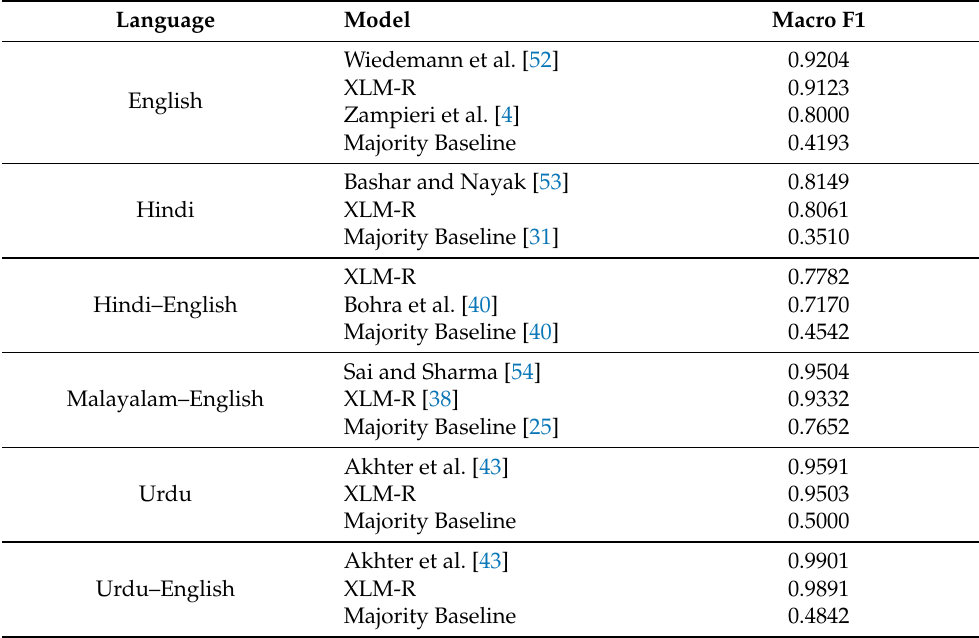
Table 3. Results ordered by Macro F1 for English, Hindi, Hindi–English, Malayalam–English, Urdu, and Urdu–English